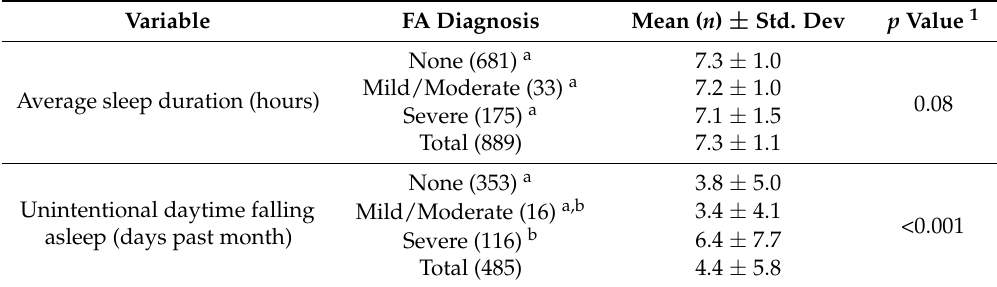
Table 3. Sleep variables (numerical) by Food Addiction